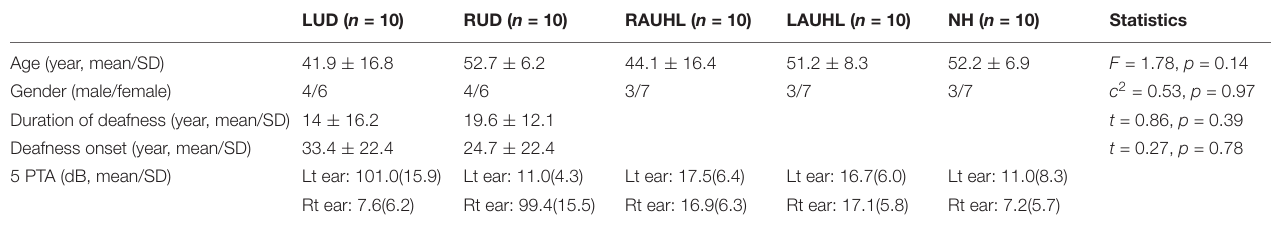
TABLE 1 | Demographic data for the unilateral deafness, acute unilateral hearing loss, and normal hearing groups.